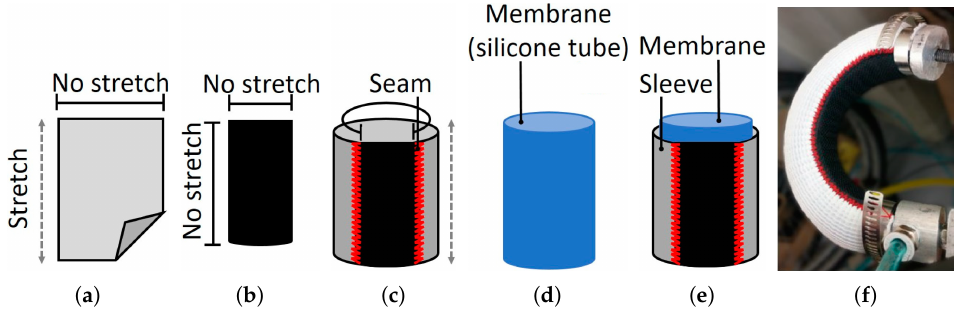
Figure 3. Structure of an actuator with an elastic sleeve [55]: ( a ) elastic band; ( b ) strain-limiting layer; ( c ) assembly of the sleeve; ( d ) silicone tube; ( e ) actuator assembly; and ( f ) actuator under